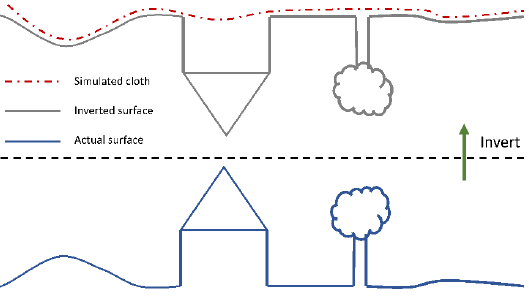
Figure 2. Overview of the Cloth Simulation Filter (CSF). Adapted from Zhang et al., 2016 [18].